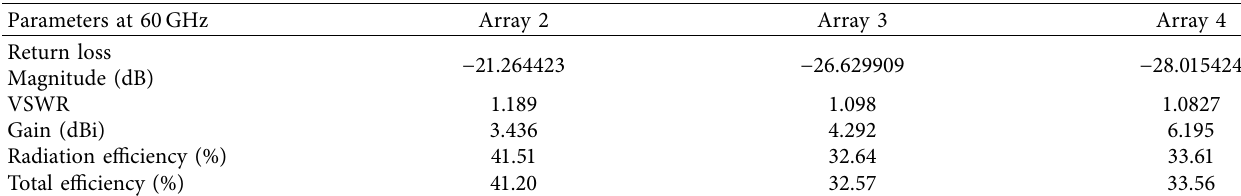
Figure 17: Surface current distribution of (a) Array 2, (b) Array 3, and (c) Array 4. Table 5: Free-space array performance